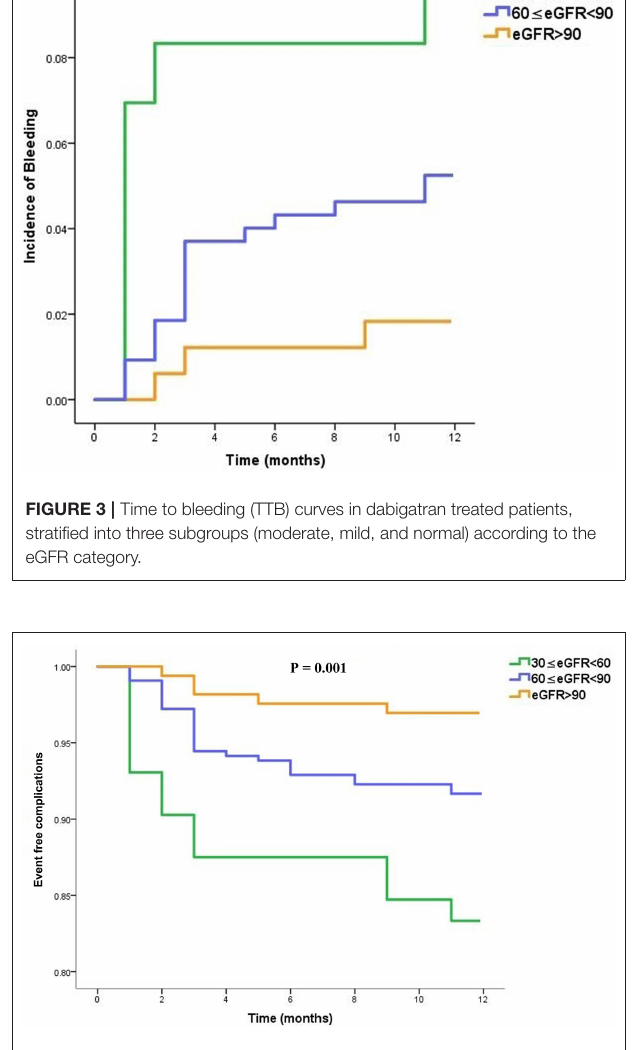
TABLE 4 | Association of the CHA 2 DS 2 -VASc and HAS-BLED score potential risk factors with composite endpoint in dabigatran-treated patients.